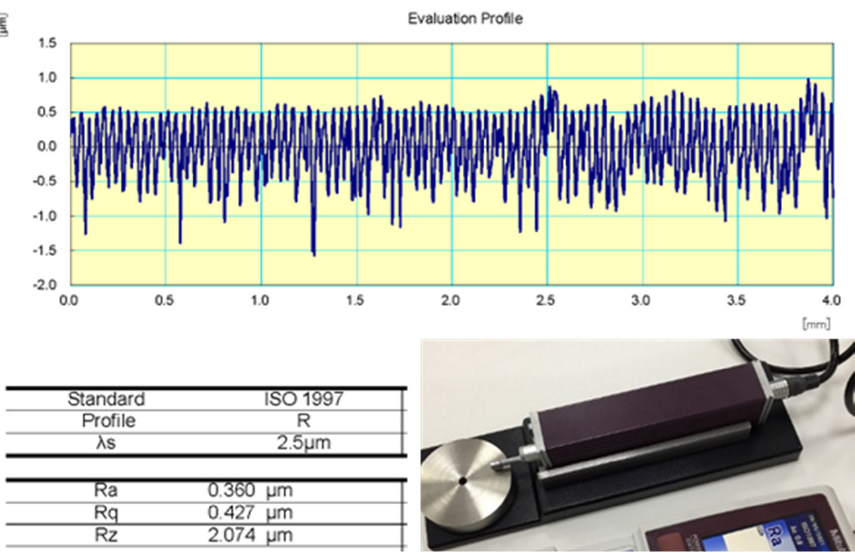
Figure 4. Roughness measurement of the sliding track (4 mm width).